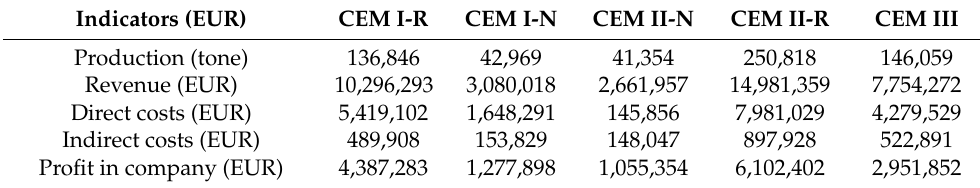
Table 8. Calculation of profit for company with assortment. Source: own source. Indicators